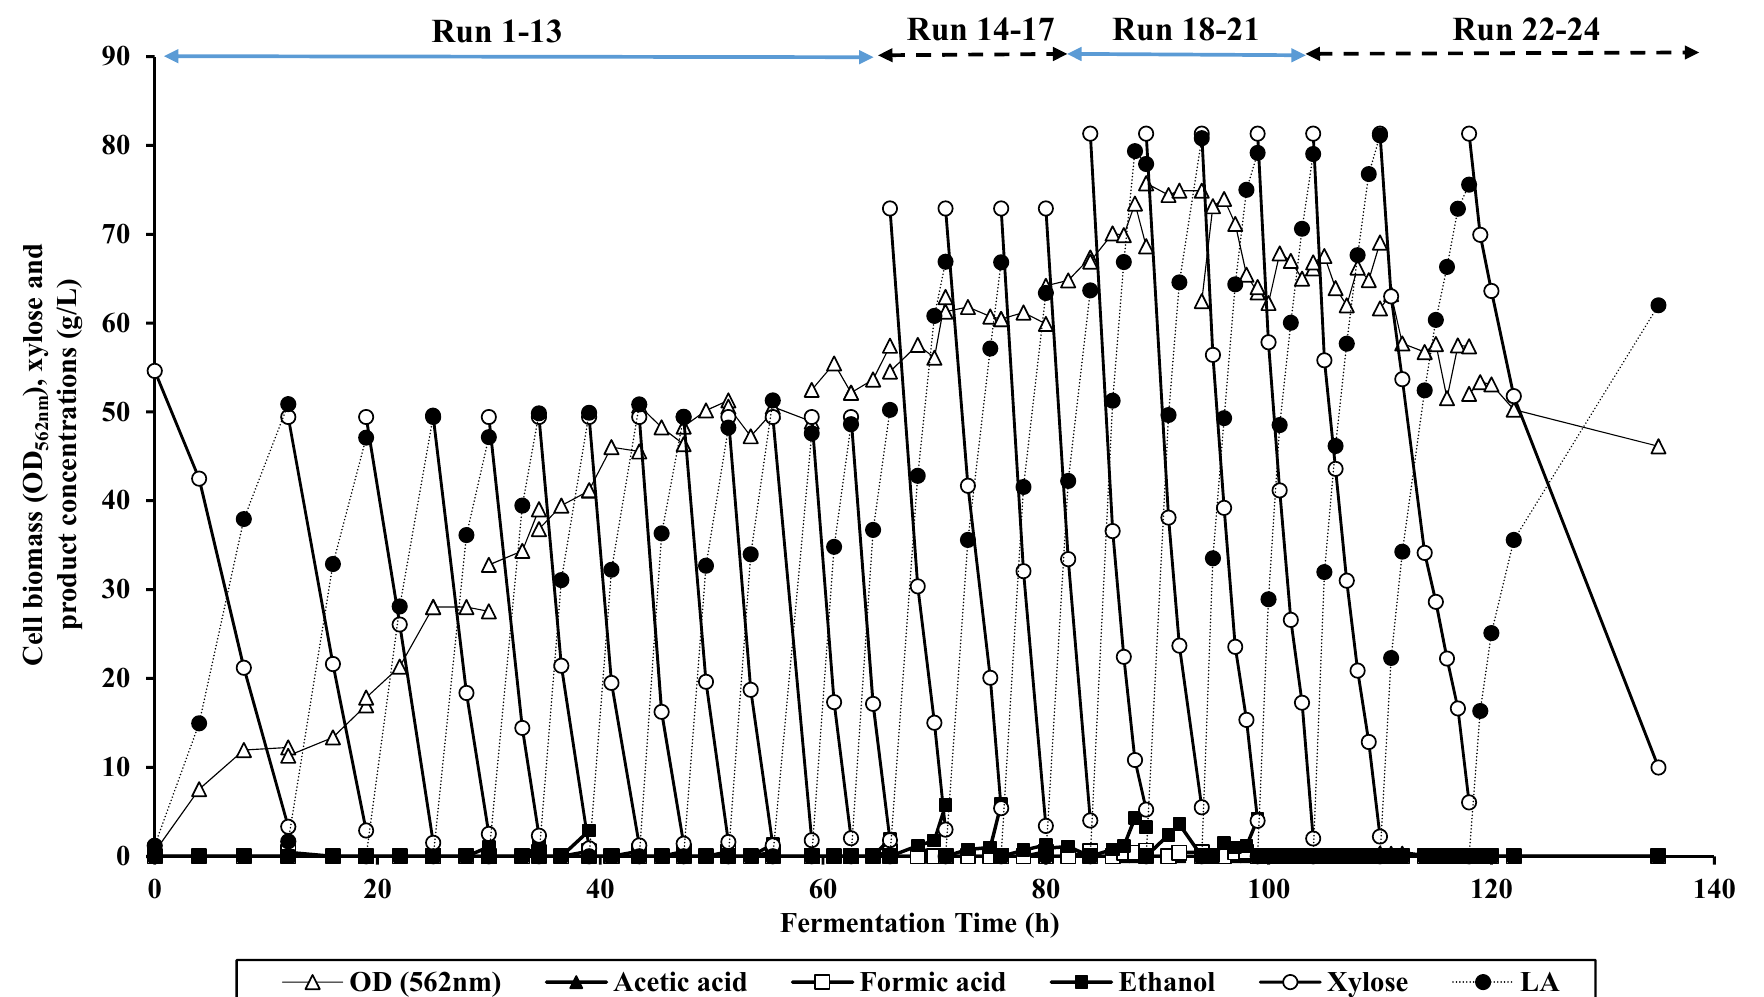
Figure 2. Profiles of repeated-batch fermentations for lactic acid production from xylose by E. faecium s6 at controlled pH 6.5 and 45 °C.